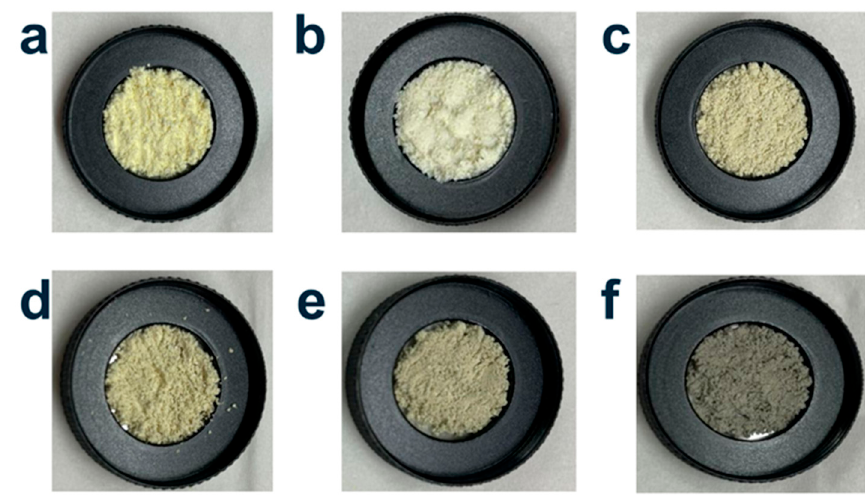
Figure 4. Photos of the ( a ) bCN, ( b ) CNS, and ( c – f ) CNQD photocatalysts.